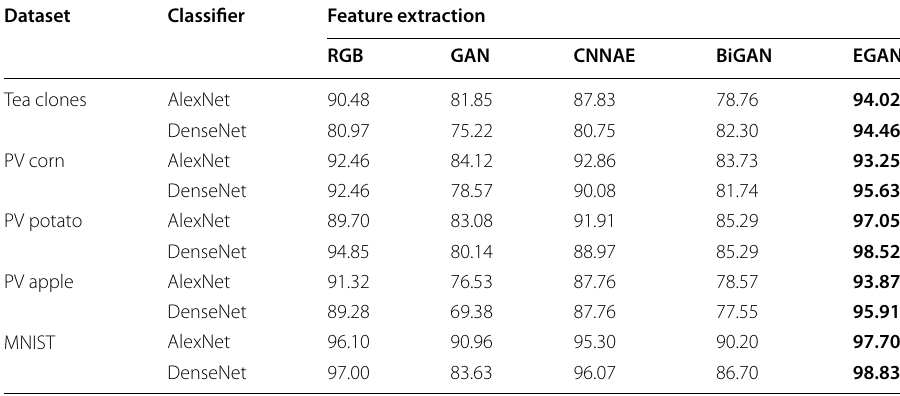
Table 3 Comparison of performance (Accuracy %) between EGAN , other features and feature learning methods